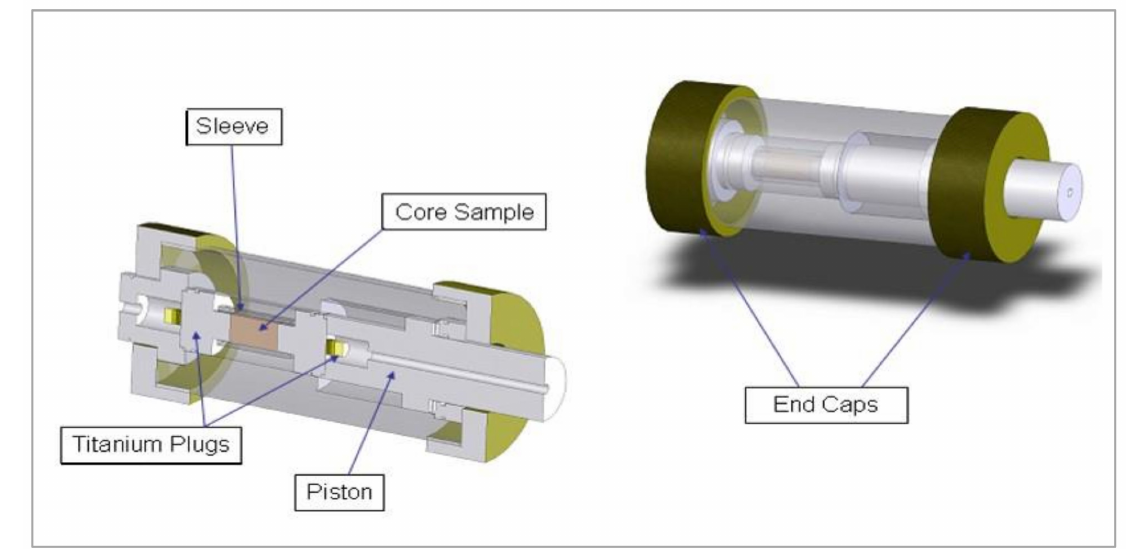
Figure 2. Triaxial core-holder in 3-dimensional ( right ) and cross-sectional ( left ) views. Six thermocouples were installed to measure/monitor temperatures at the following spots in the system: (1) inlet of the core-holder, (2) outlet of the core-holder, (3) exterior wall of the core-holder, (4) outlet port of the reservoir fluid injection pump, (5) oven ceiling, and (6) middle of the oven (air temperature) [60]. The average of temperatures at Spots (1) and (2), i.e., the inlet and the outlet of the core-holder, was used as the reservoir temperature. Temperatures at Spots (3) and (5) were used to prevent overheating. The temperature at Spot (6), compared to those at (3) and (5), was used to monitor heating homogeneity. Temperatures at Spots (4) and (1) were used to calculate properties of the injected reservoir fluid(s) and the quantity of injected mass